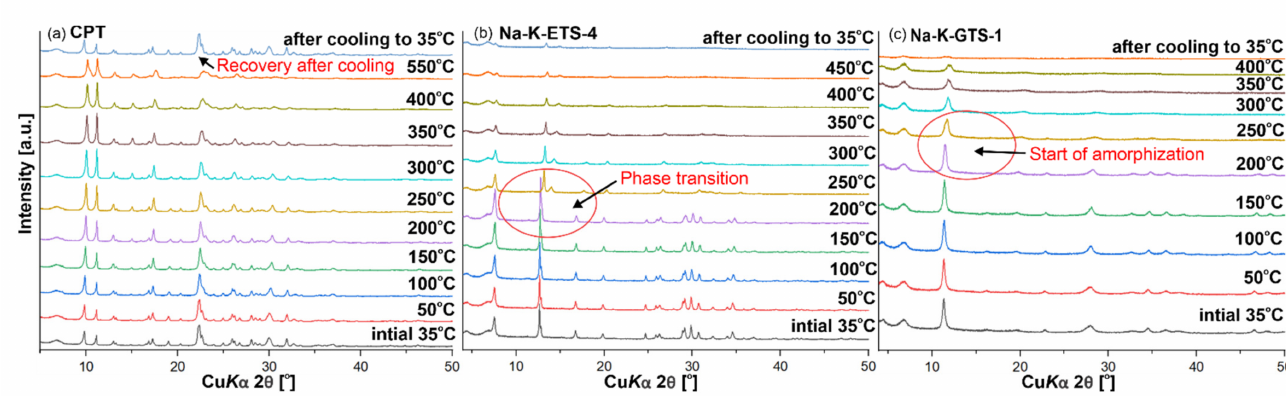
Figure 3. In situ temperature PXRD analysis of ( a ) CPT, ( b ) Na-K-ETS-4, and ( c ) Na-K-GTS-1. The topmost diffractograms at 35 ◦ C were measured after cooling down in order to see whether the material would return to its initial crystalline form.